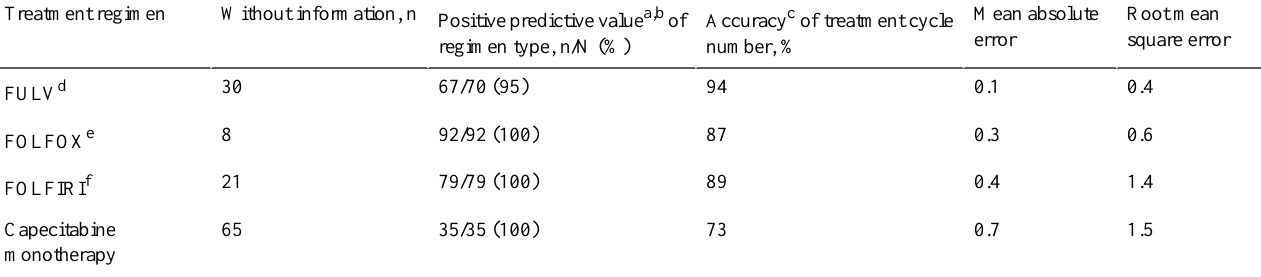
Table 2. Validation of chemotherapy episodes compared to chart